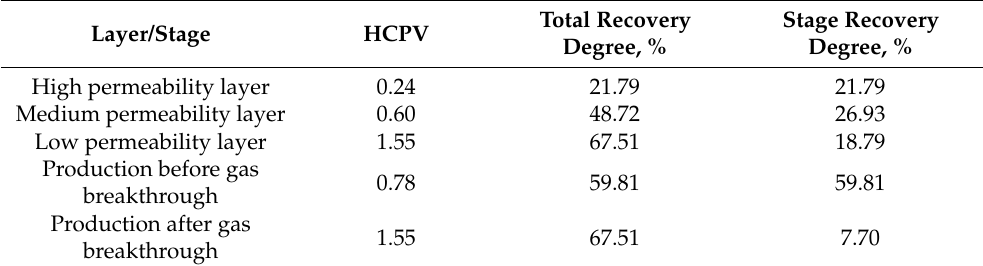
Figure 9. Relation between the recovery degree, gas–oil ratio, and injection quantity in the top gas injection process after increasing resistance. Table 4. The recovery degree of each rhythm layer after flow resistance is